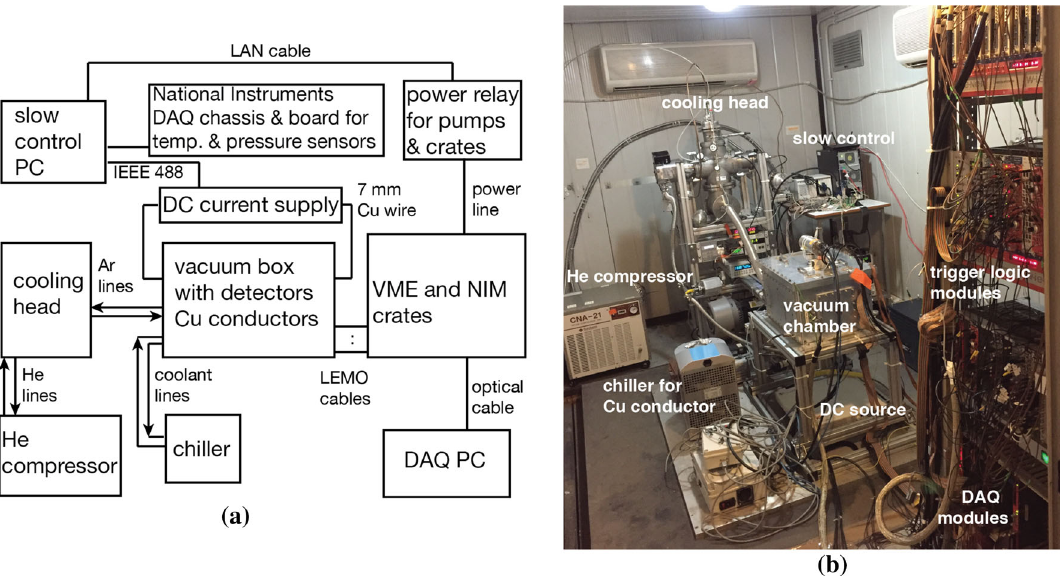
Fig. 2 a The diagram of the components of the experiment and their configuration; b a picture of the VIP-2 setup in operation at the underground laboratory of Gran Sasso the SDDs, and the analog outputs are sent via LEMO coaxial cables through the feedthroughs on the vacuum chamber to be further processed for trigger and